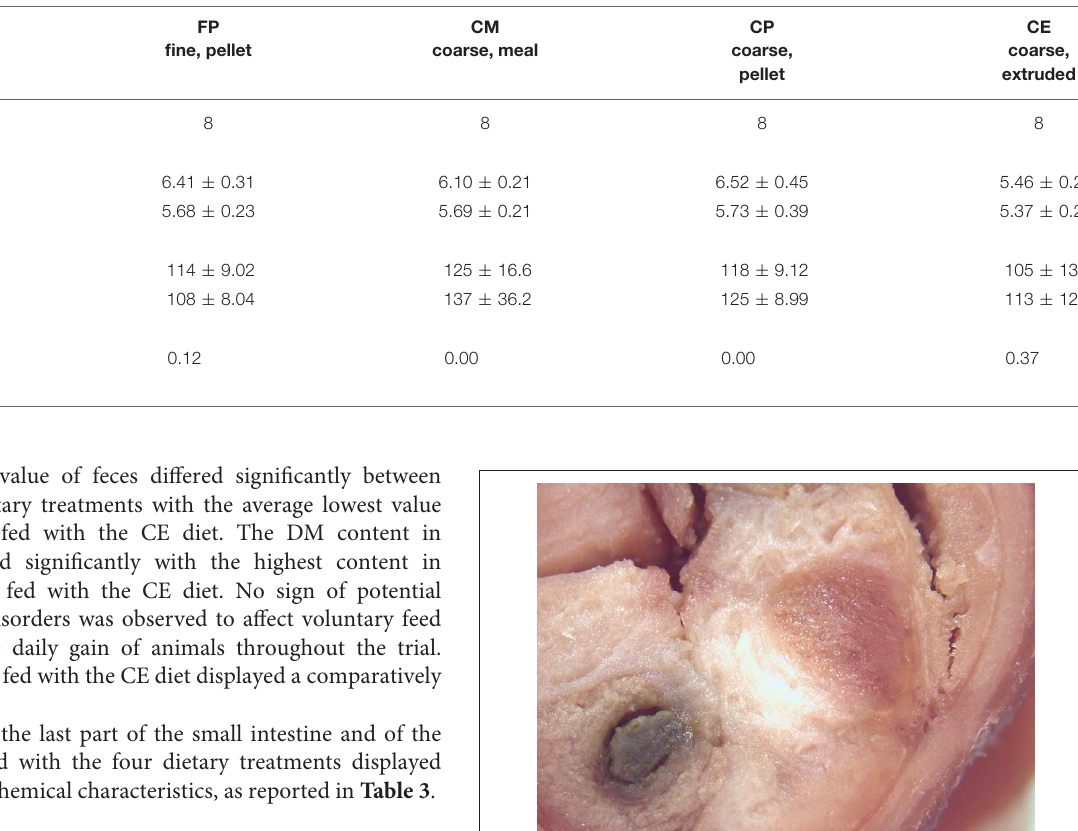
CE coarse, extruded